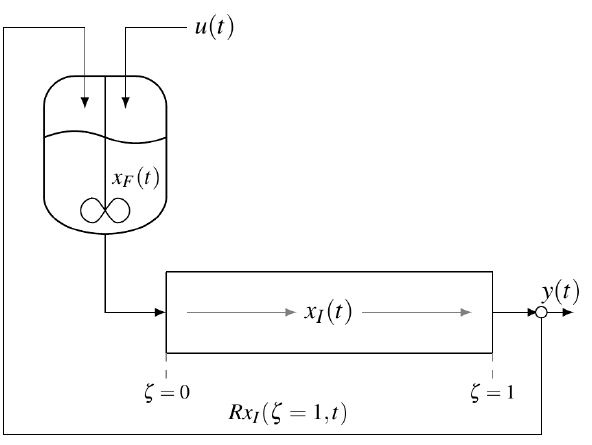
Figure 1. CSTR-tubular reactor system with recycle